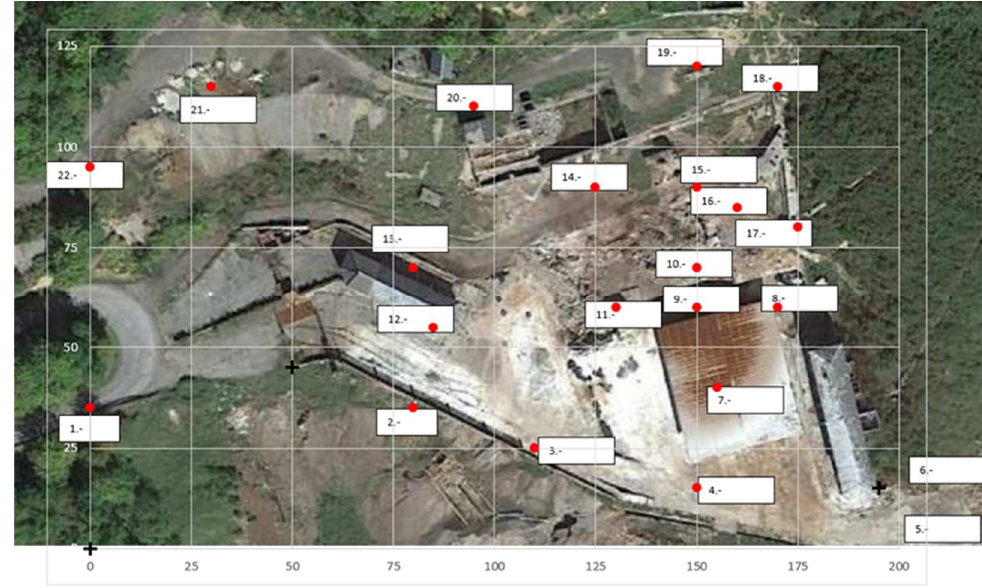
Figure 2. A depiction of the sampling route (point 6 is outside of the range of the photograph).